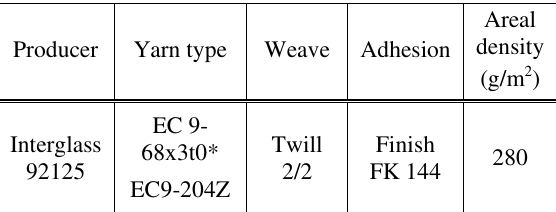
Table 1. Structure of the glass filament fabrics